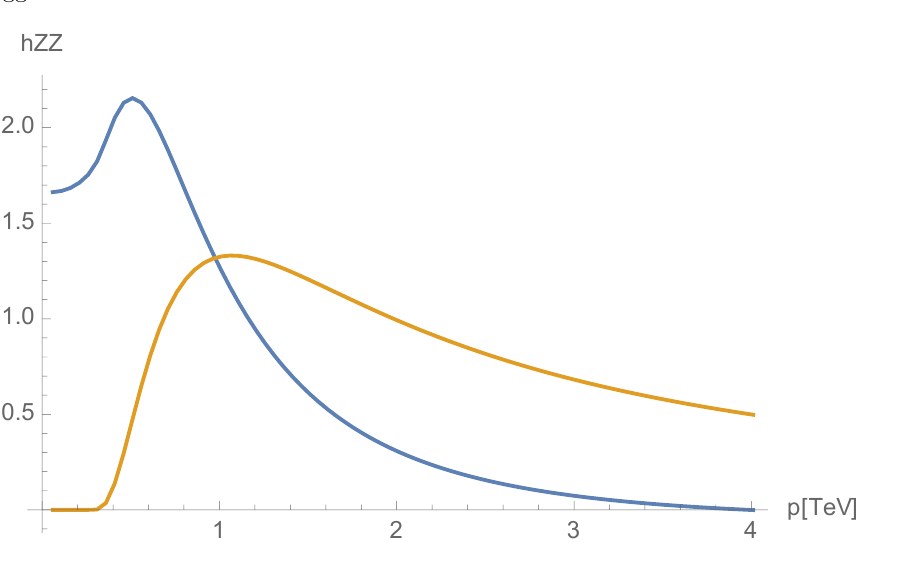
Figure 3. The e(cid:11)ective interaction in the 4D theory (left) from propagation of the (cid:12)elds in the bulk and mixing with Goldstones (denoted by dotted line) in the bulk (right). We have denoted the 4D Higgs with double dashed lines.